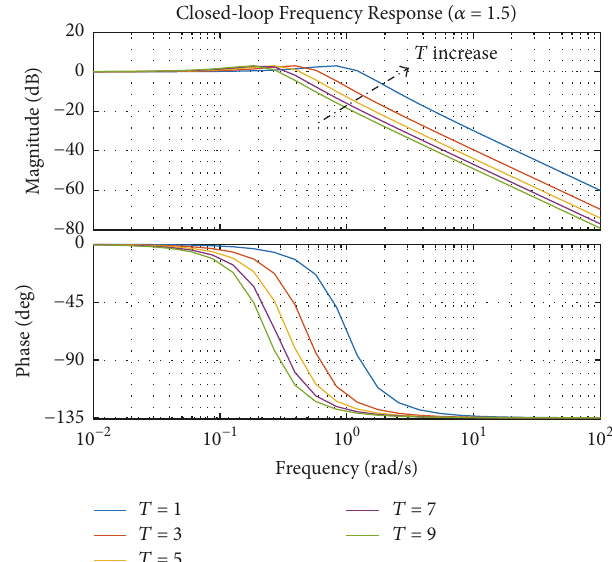
Figure 7: Frequency responses with different 𝑇 ( 𝛼 = 1.5 ).